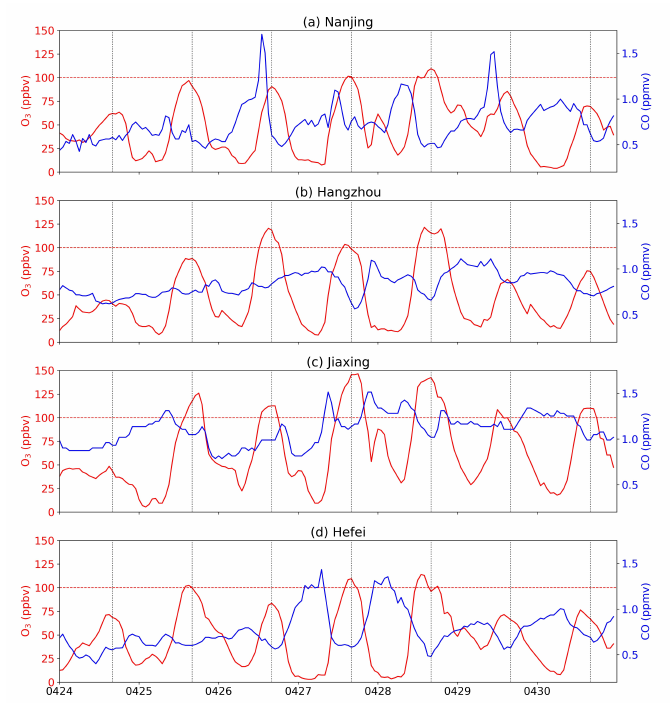
Figure 2. Time series of ground-level ozone (red lines) and CO (blue lines) concentration in eastern China from 24 April 2018 to 30 April 2018. ( a ) Nanjing, ( b ) Hangzhou, ( c ) Jiaxing and ( d ) Hefei. The horizontal red dashed line indicates the value of 100 ppbv of ozone concentration. The vertical black dotted lines indicate 16:00 of each day (local time), which is approximately the time of the maximal values of the diurnal